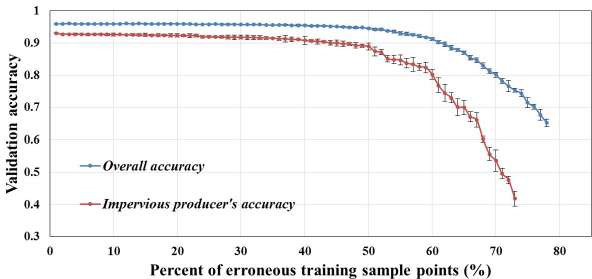
Figure 16. The relationship between overall accuracy and impervi- ous producer’s accuracy with the percentage of erroneous training samples using the random forest classification